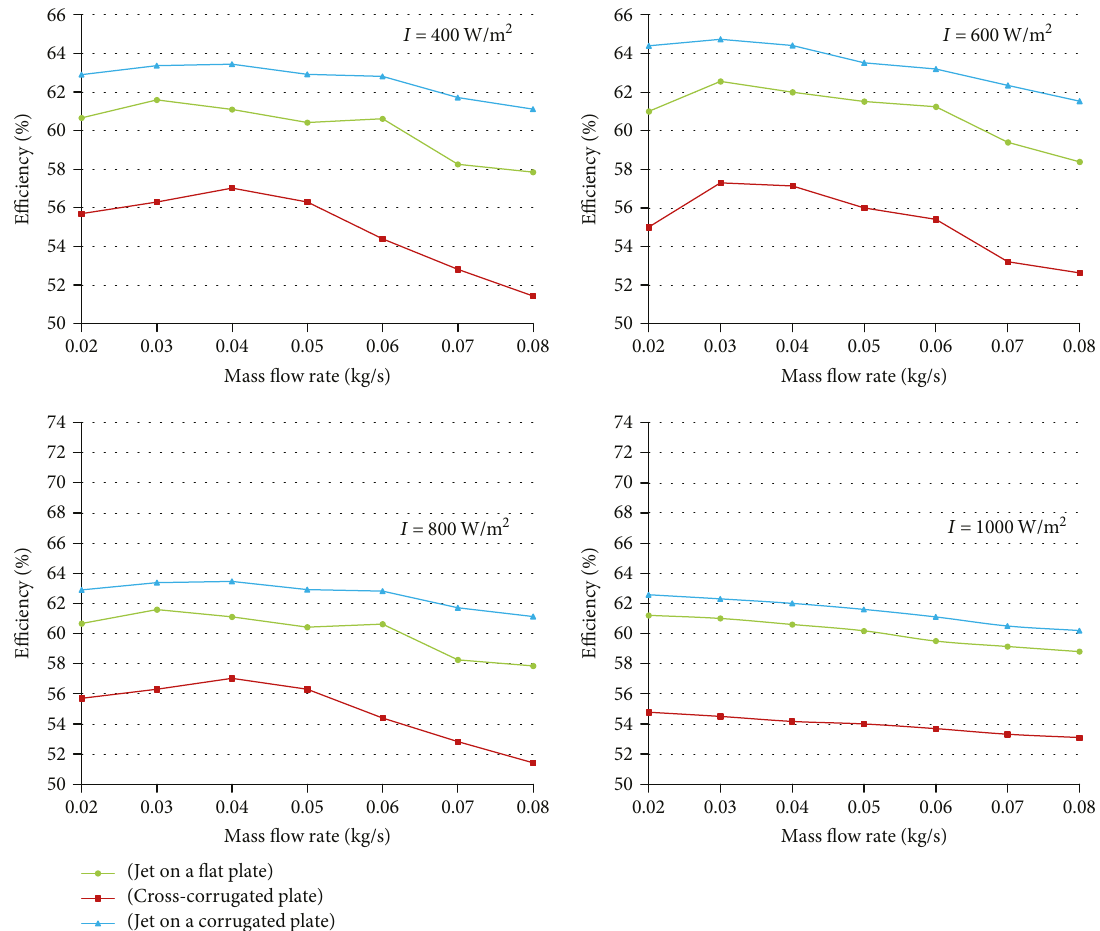
Figure 17: SAH E ffi ciency under the purview of three collector designs versus mass fl ow rate for di ff erent solar radiation levels.